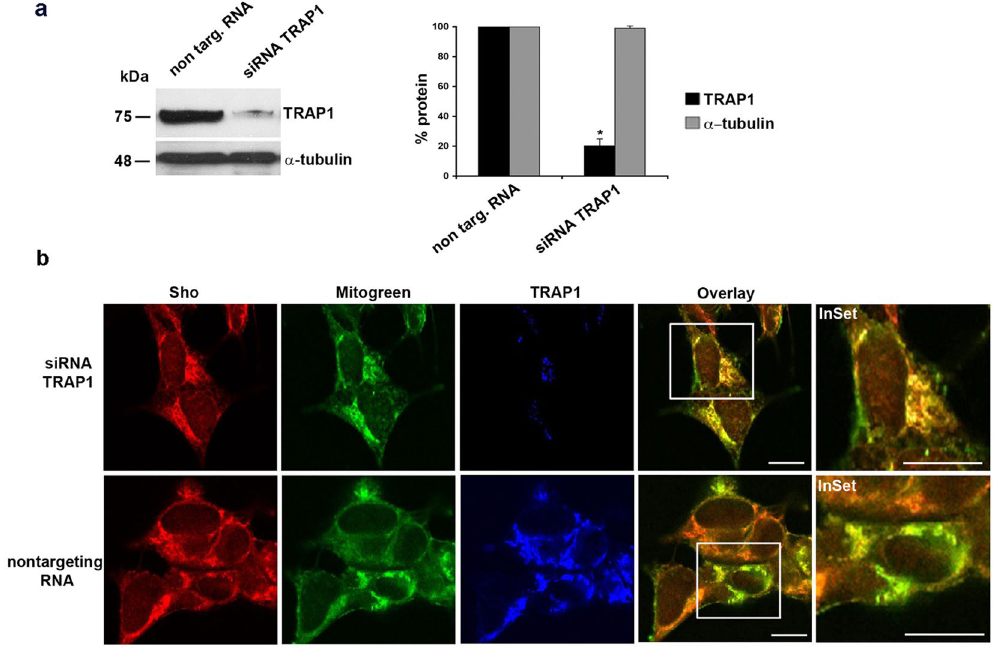
Figure 4. Knockdown of TRAP1 expression regulates mitochondrial localization of Sho in SH-SY5Y cells. ( a ) SH-SY5Y cells were lysed in Buffer 1 and processed for western blotting by using anti-TRAP1 Ab and anti-alpha-tubulin Ab as loading control. TRAP1 was silenced using a specific siRNA for 72 h. In comparison to siRNA TRAP1 cells, 50 μ g of total cell lysate from control cells (non targ. RNA) were loaded for reference. PVDF membranes were processed for western blotting analysis by using anti-TRAP1. The same membranes were probed with anti-tubulin Ab followed by ECL detection. The amount of silenced TRAP1 was quantified from three independent experiments. * P < 0.05. ( b ) siRNA TRAP1 SH-SY5Y (upper panel) and non targeting RNA control cells (bottom panel) were processed for triple immunofluorescence analysis by using anti-Sho SPRN-R12 and anti- TRAP1 Ab followed by secondary conjugated Alexafluor-546 and Cy5 Abs, respectively. Mitotracker green (15 min at 37 °C in culture medium) was used to mark mitochondria (green). Overlay is between red and green channels. Colocalization was analysed in at least 52 cells per experiments (N = 3). P < 0.03. Scale bars: 10 μ